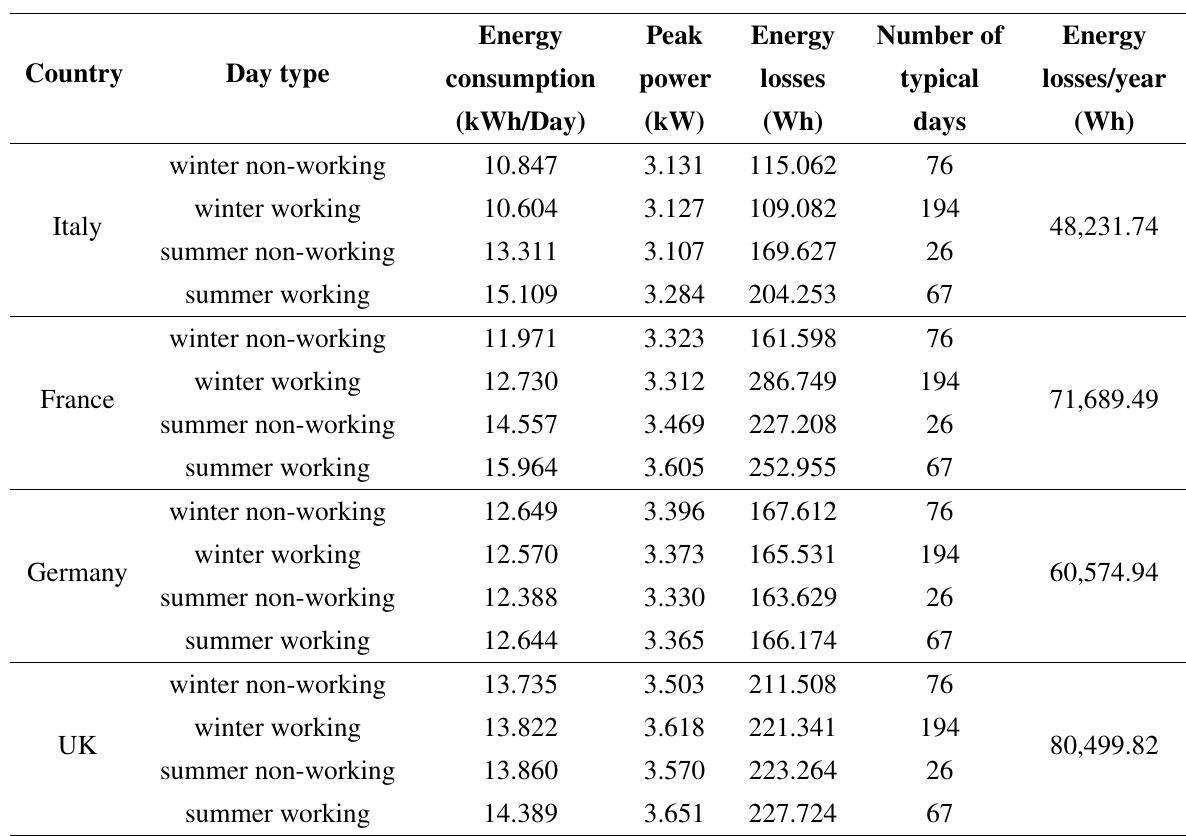
Table 4. House energy losses per country-scenario